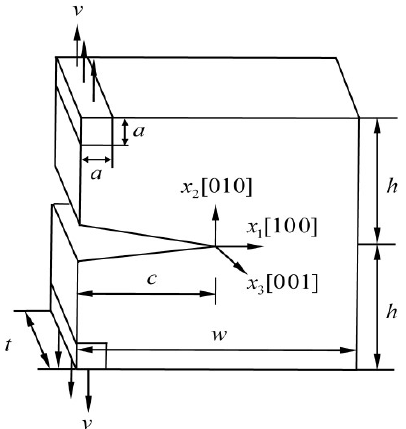
Figure 1. Atomic model geometry for the Cu and Ni nanoplates containing an edge crack of length c . A tensile displacement v is applied to the boundary regions located at the left upper and lower corners.